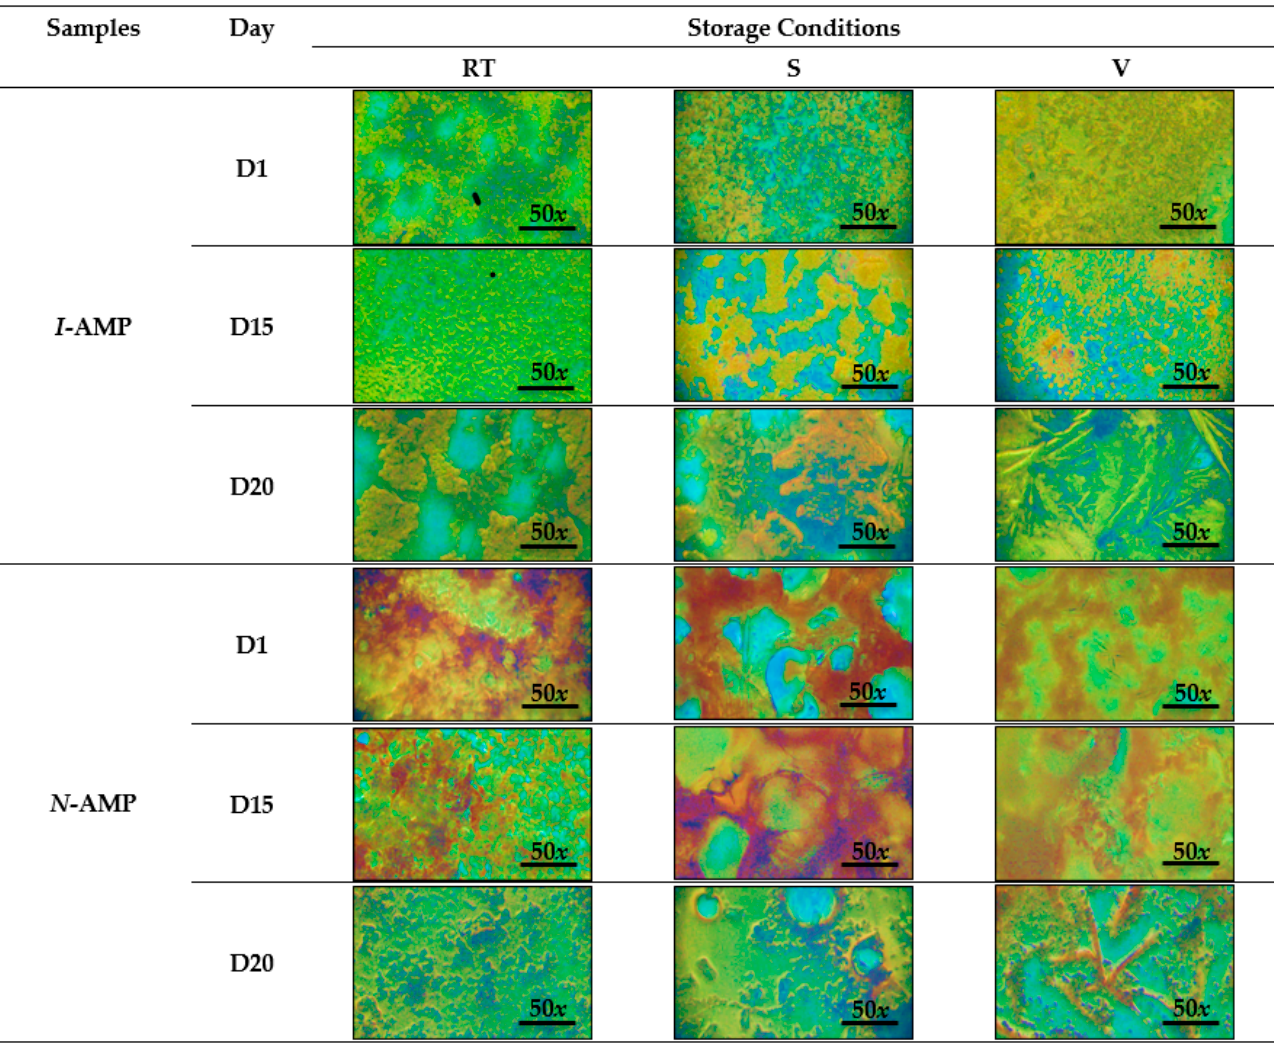
Figure 5. Optical microscopy images of I ‐ AMP and N ‐ AMP at room temperature (RT), silica (S) and vacuum (V) for D1, D15 and D20.